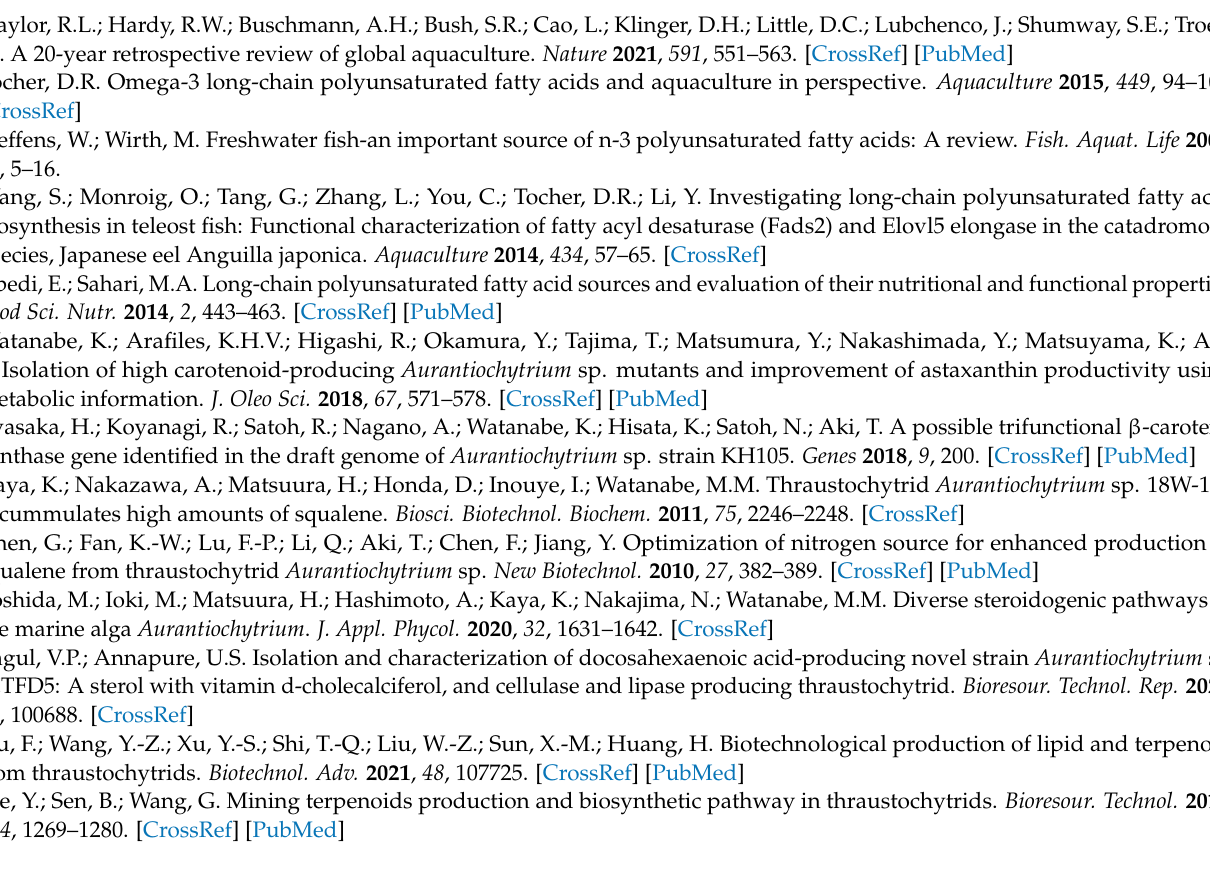
ents; Table S2: The Product Numbers of Commercial Assay kits; Table S3: Primers Used for Detection of